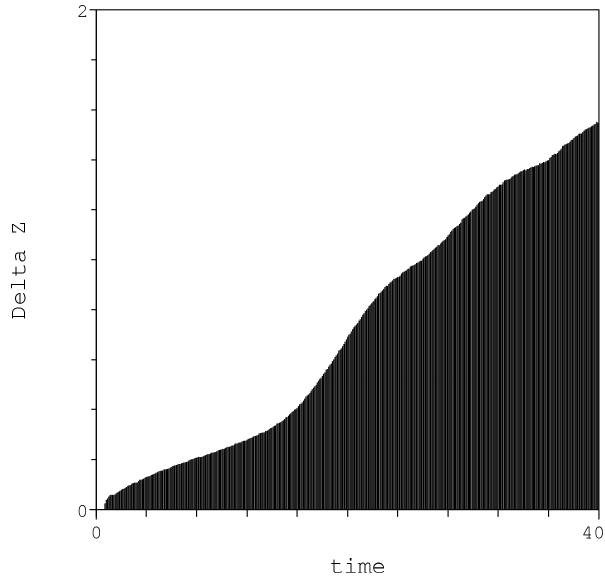
Fig. 4. Time evolution of the δZ = N T /n 0 X m layer